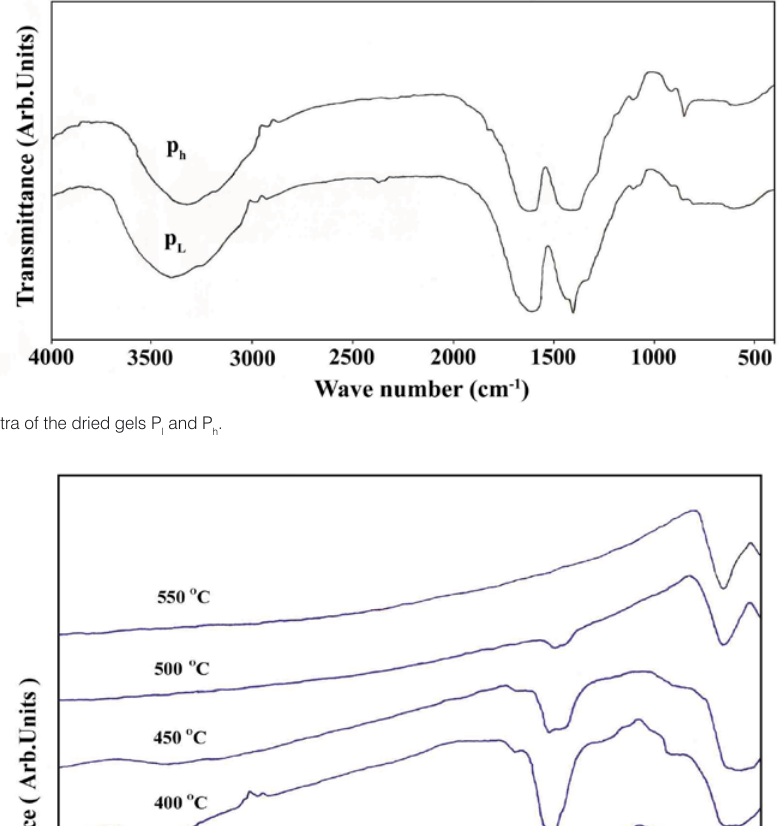
calcined at various h